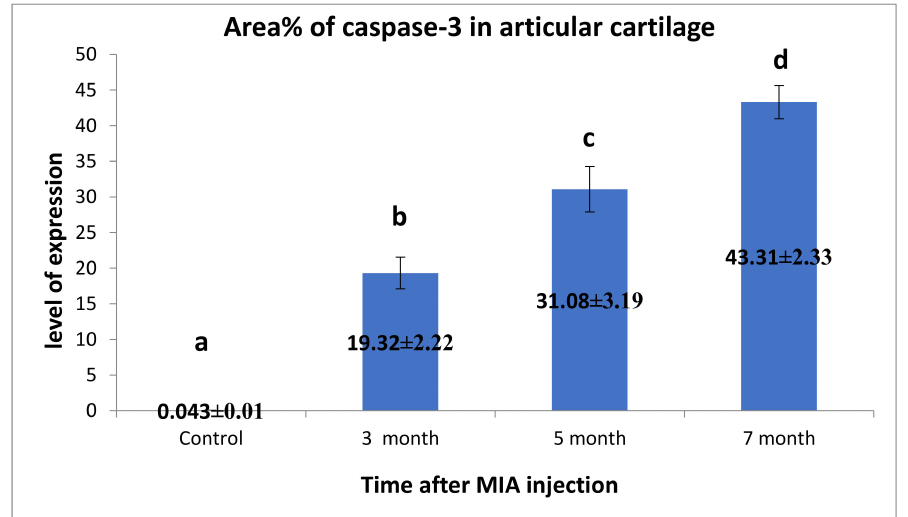
Figure 11. Immunohistochemical analysis for area% of Caspase-3 in examined articular cartilage revealed increased expression of Caspase-3 in chondrocytes compared to control. The expression of Caspase-3 increased with the increase of time post-MIA injection. Data presented as the mean ± SEM for triplicate samples ( n = 3). Values with the same letters are non-significantly di ff erent ( p > 0.05), while the values of di ff erent letters are significantly di ff erent ( p <